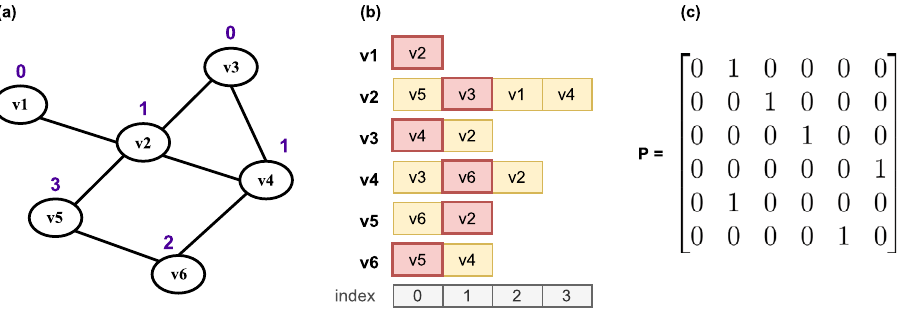
Figure 6. ( a ) Graph topology annotated with the number of interactions count i initiated by each node. ( b ) List of neighbours for each node in random order. The value of count i identifies the position in the neighbour list of count i % deg ( v i ) . In this implementation, the index of the next node to contact according to the formula o = the first element in the lists is 0. ( c ) Probability matrix of order selection for this configuration. In this example, 3%2 1 , meaning that the next node to select is at node v 5 has 2 neighbours and has interacted 3 times, so o = = index 1 of the neighbour list, i.e. v 2 . At the next interaction, v 5 will select v 2 with probability